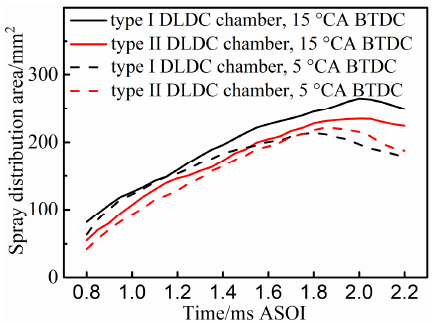
Figure 21. The comparison of fuel spray distribution areas between the two DLDC chambers with a Ф 0.18 mm nozzle, 150 MPa injection pressure and different injection timings.